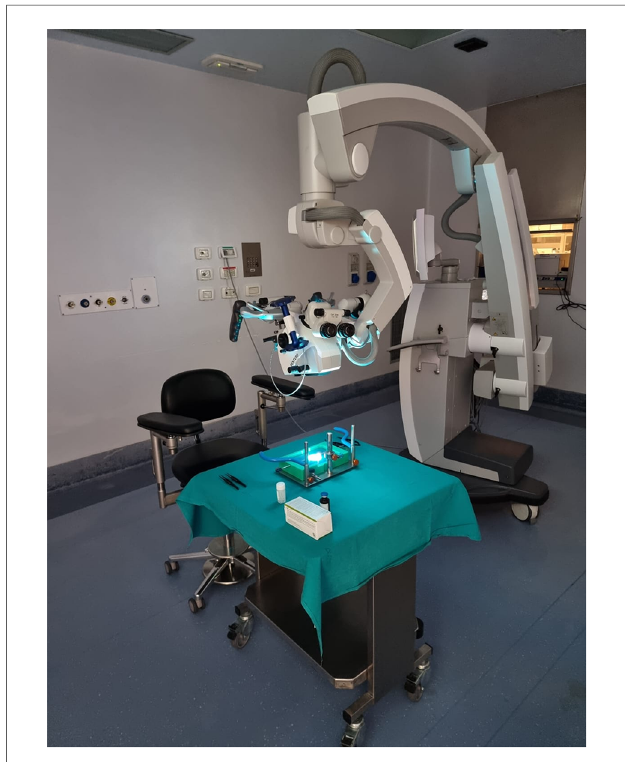
FIGURE 3 Workstation. The training platform has to be placed on a stable